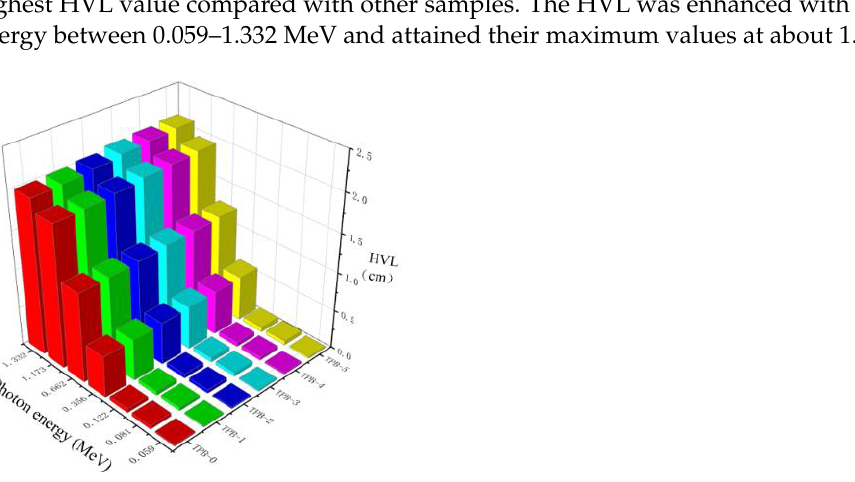
Figure 5. Half value layer (HVL) of TPB glass system under different photon energy and chemical composition.